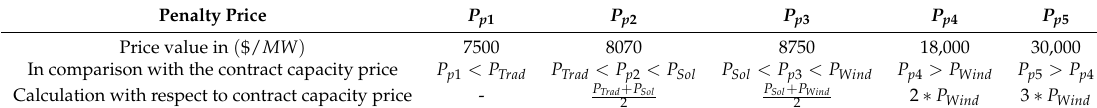
Table 2. Assumed penalty prices value and description.